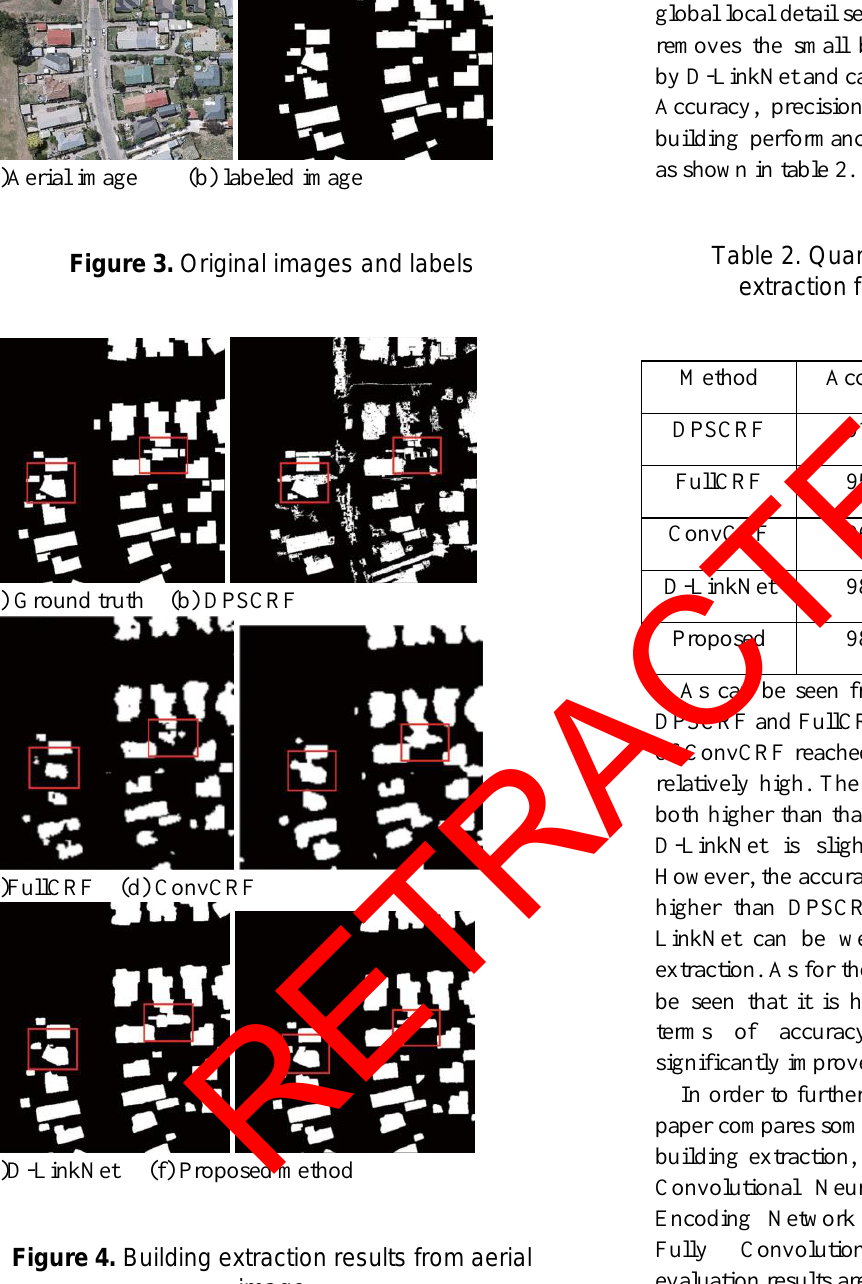
Figure 4. Building extraction results from aerial image